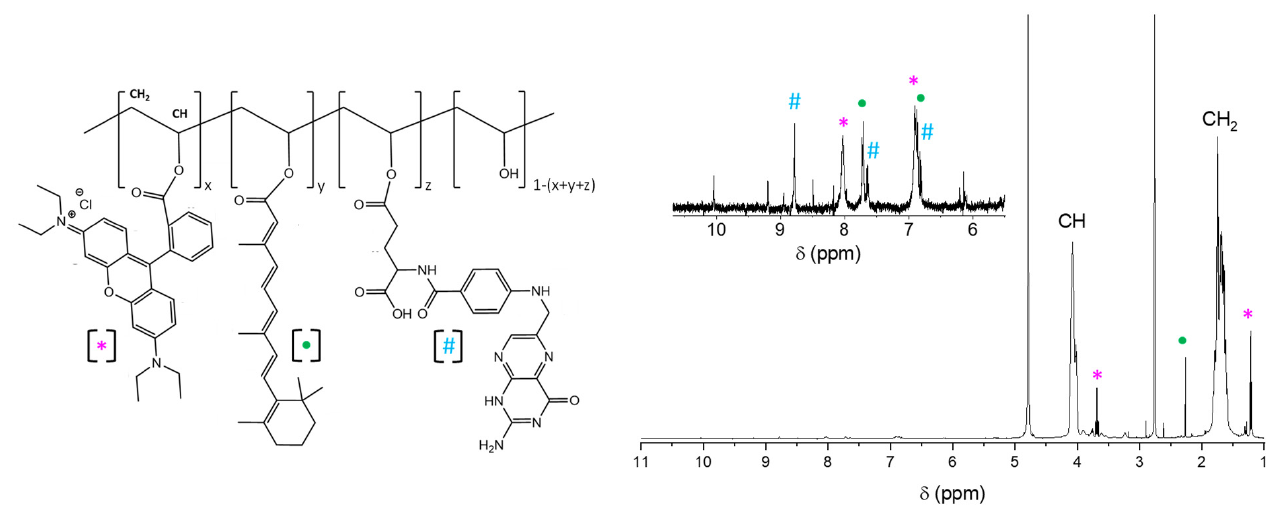
Figure 6. 1 H-NMR spectrum ( right ) of PVA@RhodFR (D 2 O) , with the respective molecular structure ( left ) for signals attributions (*, Rhodamine B; • , ATRA; #, Folic